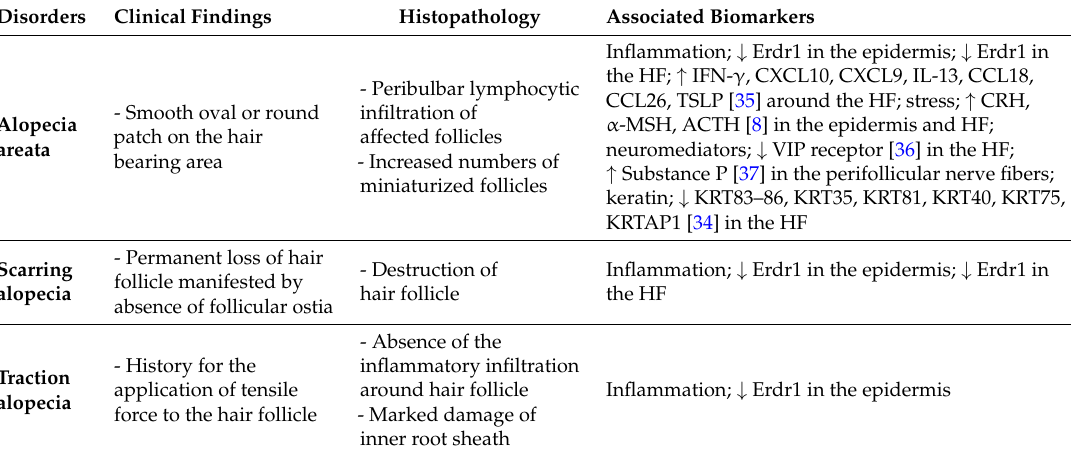
Table 2. Proposed diagnostic clues for various hair loss disorders.